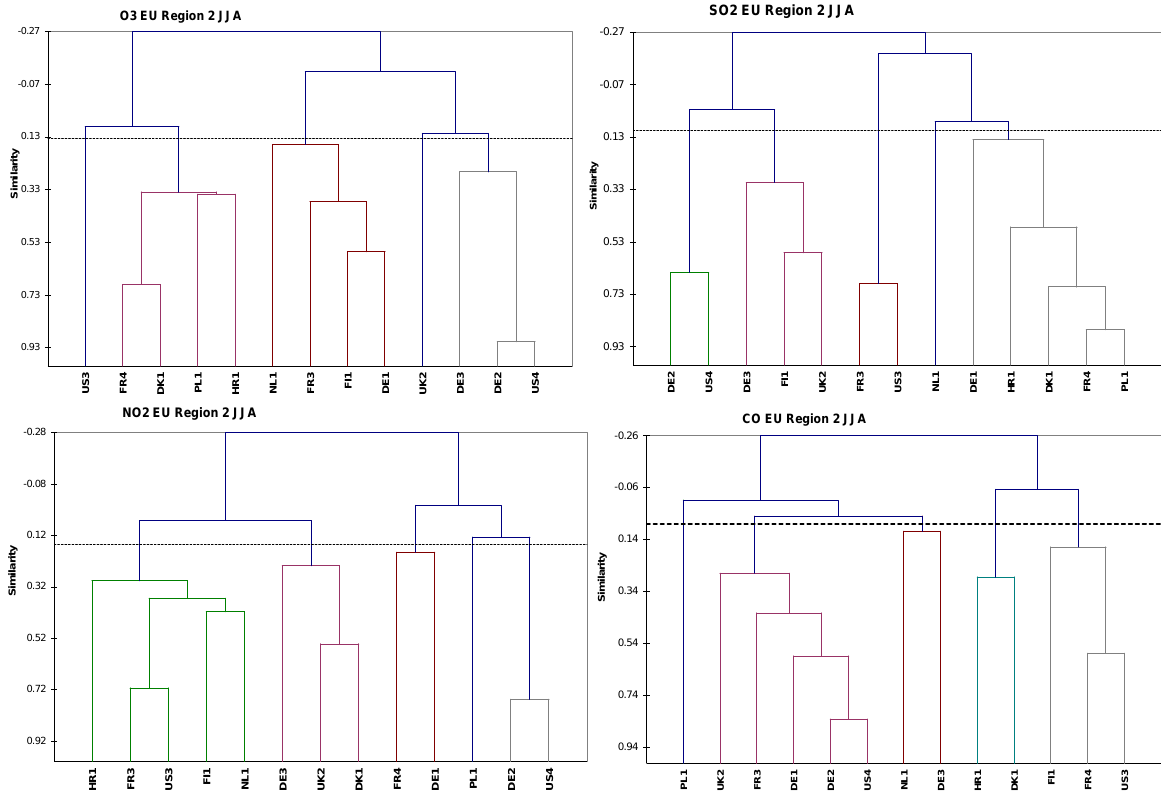
Fig. 6. Hierarchical clustering of corr( d i , d j ) for EU region 2. The dotted horizontal line defines the level of similarity. Disjoint clusters are identified by different